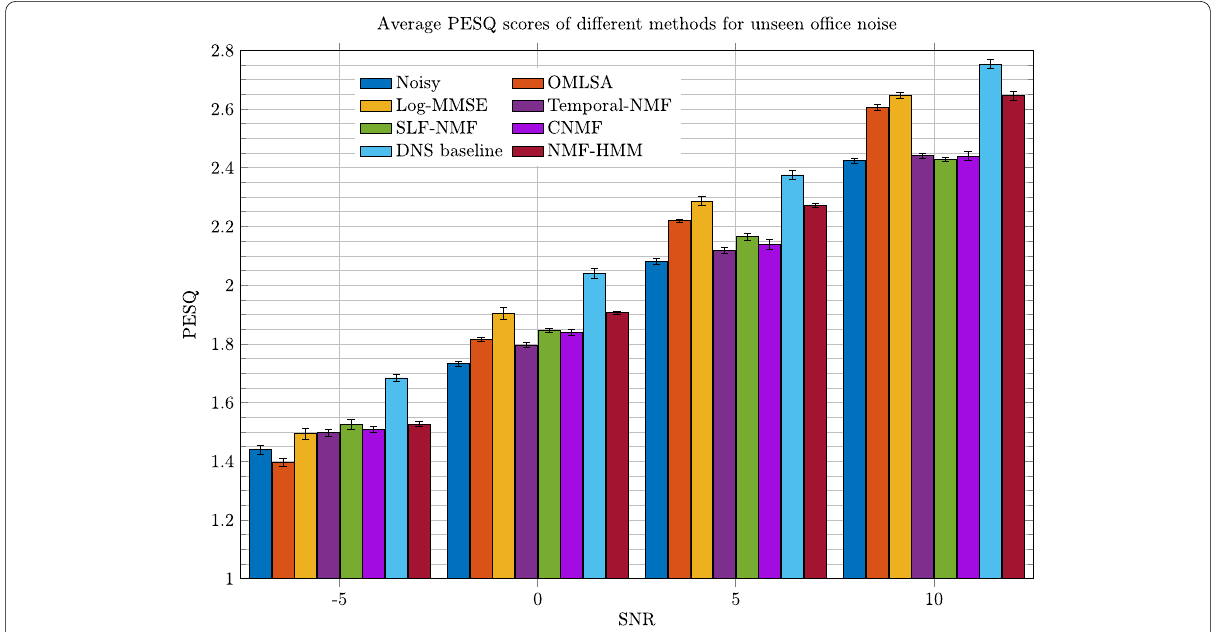
Fig. 4 Average PESQ scores of different methods for unseen office noise